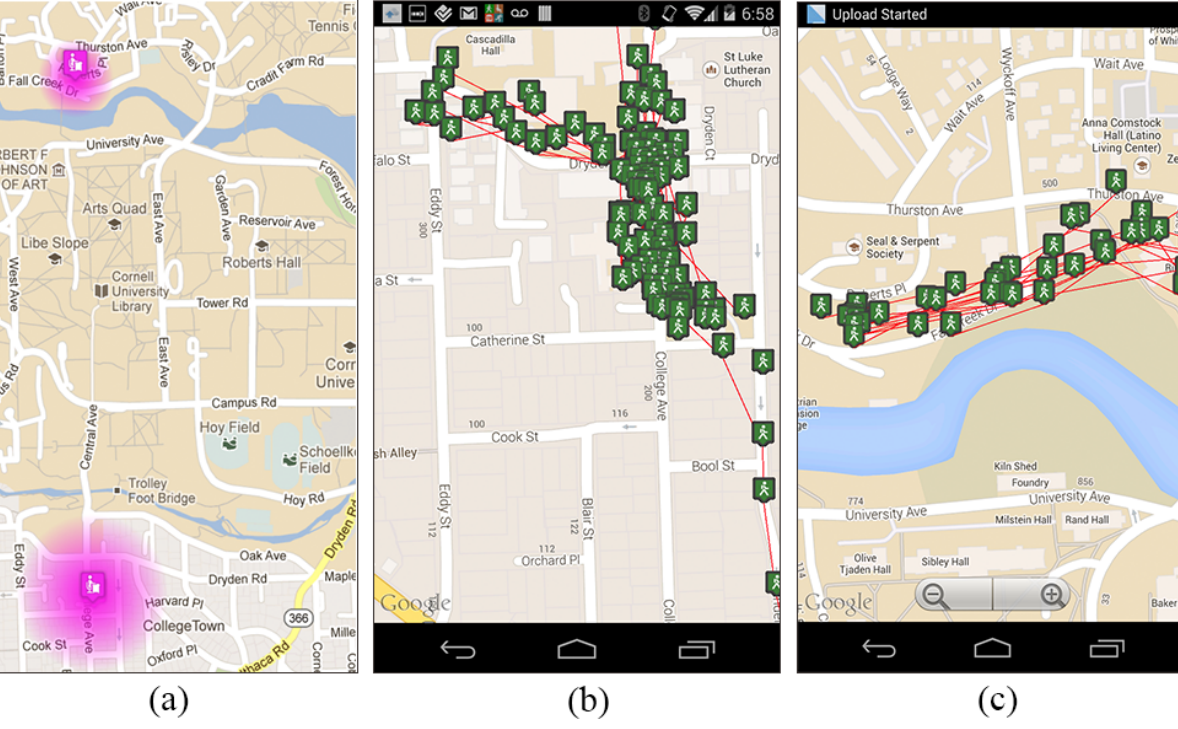
Figure 3. Clusters generated from user activities: (a) locations where user A stayed stationary, (b) location traces for user B where he walked around his office, and (c) walking traces of user A from his house to the bus